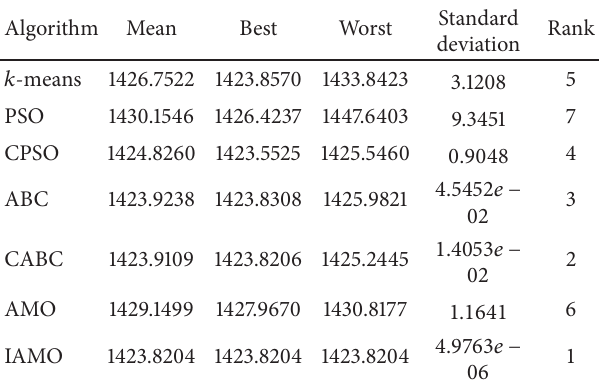
Table 9: Results obtained by the algorithms for 20 different runs on balance scale data.